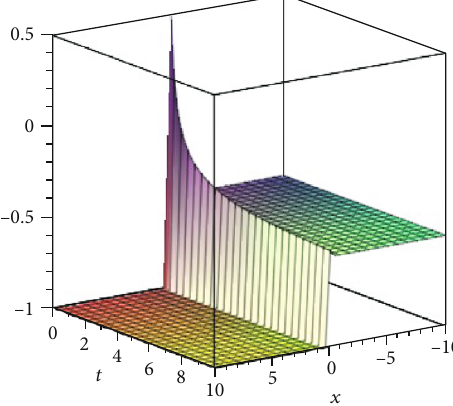
ð x , 0, t Þ of Equation (21). Figure 2: u 2,1